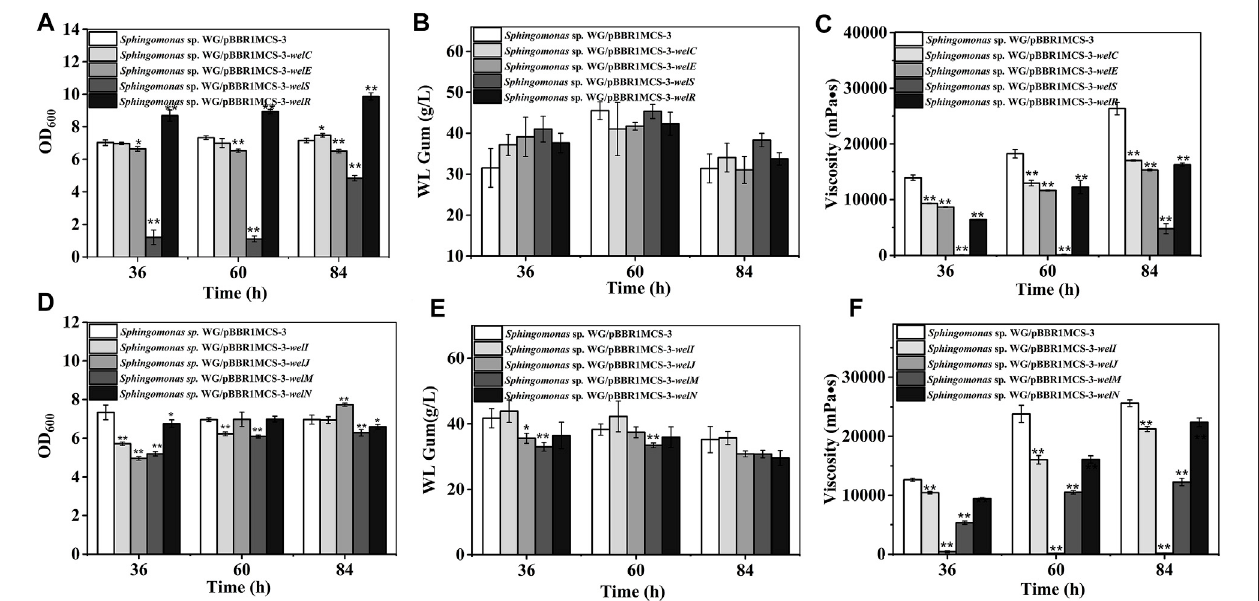
FIGURE 4 | Fermentation results of over-expression strains containing genes involved in polymerization and export process. (A) Comparison of biomass of Sphingomonas sp. WG/pBBR1MCS-3- welC , Sphingomonas sp. WG/pBBR1MCS-3- welE,Sphingomonas sp.WG/pBBR1MCS-3- welS ,and Sphingomonas sp. WG/ pBBR1MCS-3- welR . (B) Comparison of WL gum production of Sphingomonas sp. WG/pBBR1MCS-3- welC , Sphingomonas sp. WG/pBBR1MCS-3- welE, Sphingomonas sp.WG/pBBR1MCS-3- welS ,and Sphingomonas sp.WG/pBBR1MCS-3- welR . (C) Comparisonoffermentationbrothviscosityof Sphingomonas sp. WG/pBBR1MCS-3- welC , Sphingomonas sp.WG/pBBR1MCS-3- welE, Sphingomonas sp. WG/pBBR1MCS-3- welS , and Sphingomonas sp. WG/pBBR1MCS-3- welR . (D) Comparisonofbiomassof Sphingomonas sp.WG/pBBR1MCS-3- welI , Sphingomonas sp.WG/pBBR1MCS-3- welJ,Sphingomonas sp.WG/pBBR1MCS-3- welM , and Sphingomonas sp. WG/pBBR1MCS-3- welN . (E) Comparison of WL gum production of Sphingomonas sp. WG/pBBR1MCS-3- welI , Sphingomonas sp. WG/pBBR1MCS-3- welJ, Sphingomonas sp. WG/pBBR1MCS-3- welM , and Sphingomonas sp. WG/pBBR1MCS-3- welN . (F) Comparison of fermentation broth viscosity of Sphingomonas sp. WG/pBBR1MCS-3- welI , Sphingomonas sp. WG/pBBR1MCS-3- welJ, Sphingomonas sp. WG/pBBR1MCS-3- welM , and Sphingomonas sp. WG/pBBR1MCS-3- welN . The fermentation was preformed in 250 ml shaking fl asks containing 50 ml fermentation medium (67 g/L Glc, 3.4